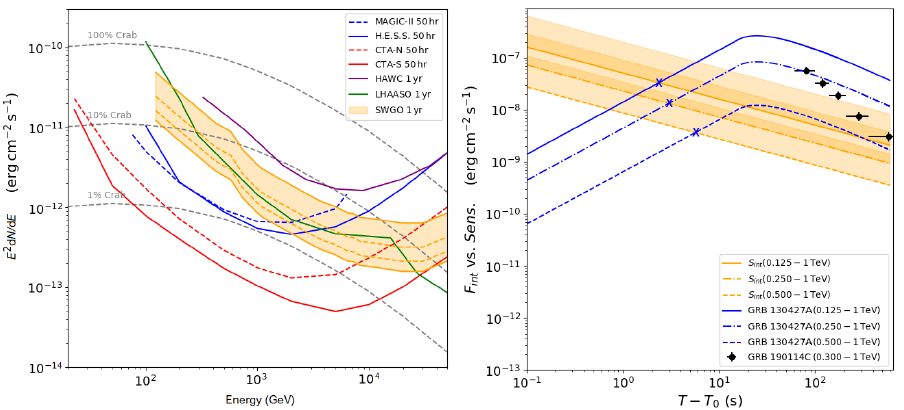
Figure 4. ( Left panel ) Differential sensitivity to the flux of a point-like source located at zenith distance ϑ = 20 o for SWGO, HAWC and LHAASO (computed for 1year of data taking) and for MAGIC, H.E.S.S. and CTA (computed for 50h of exposure time). Different fractions of the Crab Nebula flux are also shown for comparison. ( Right panel ) Expected detection times for a GRB with the temporal and spectral characteristics of GRB 130427A, located at redshift z = 0.34, for different fractions of the optimal SWGO performance, taken integrating the spectrum above thresholds of E = 125GeV, 250GeV and 500GeV. For each case, the blue crosses mark the time required to accumulate an integrated flux above the corresponding detection threshold. The black points with error bars denote the temporal evolution of the VHE flux detected by MAGIC for E (cid:62) 300GeV from GRB 190114C